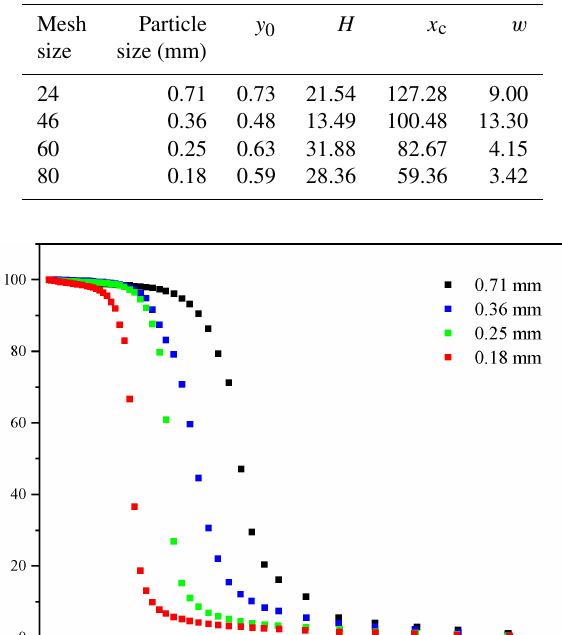
Table 2. Gaussian function characteristic values for four permeable stones with different particle sizes.